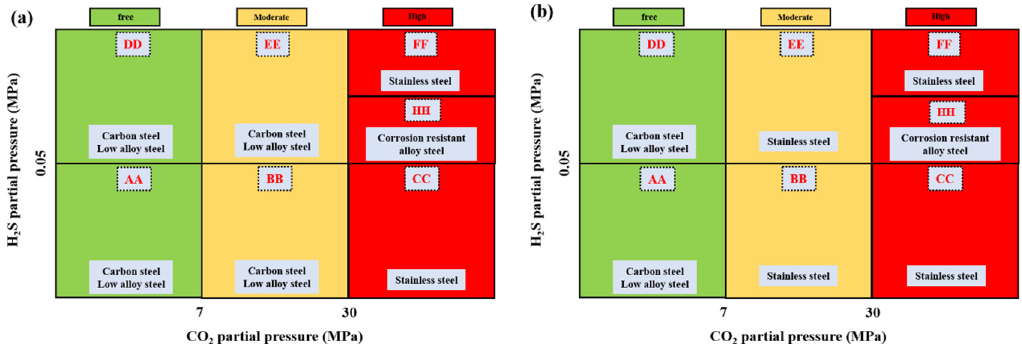
Figure 1. Application environment classification and material selection of wellhead. ( a ): body, cover, port, and outlet connection; ( b ): Pressure control parts.